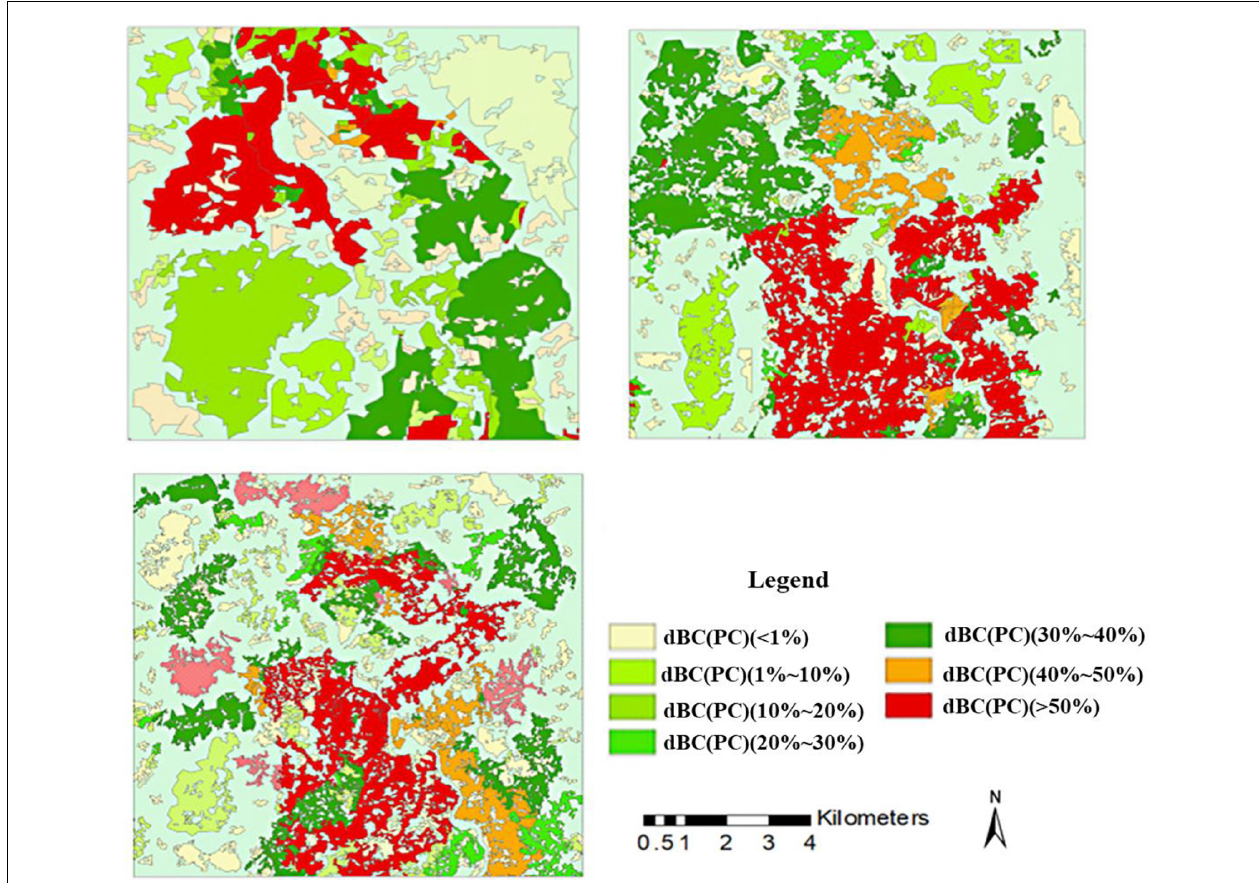
FIGURE 6 | Dynamics of the Betweenness Centrality BC (PC) index in the three